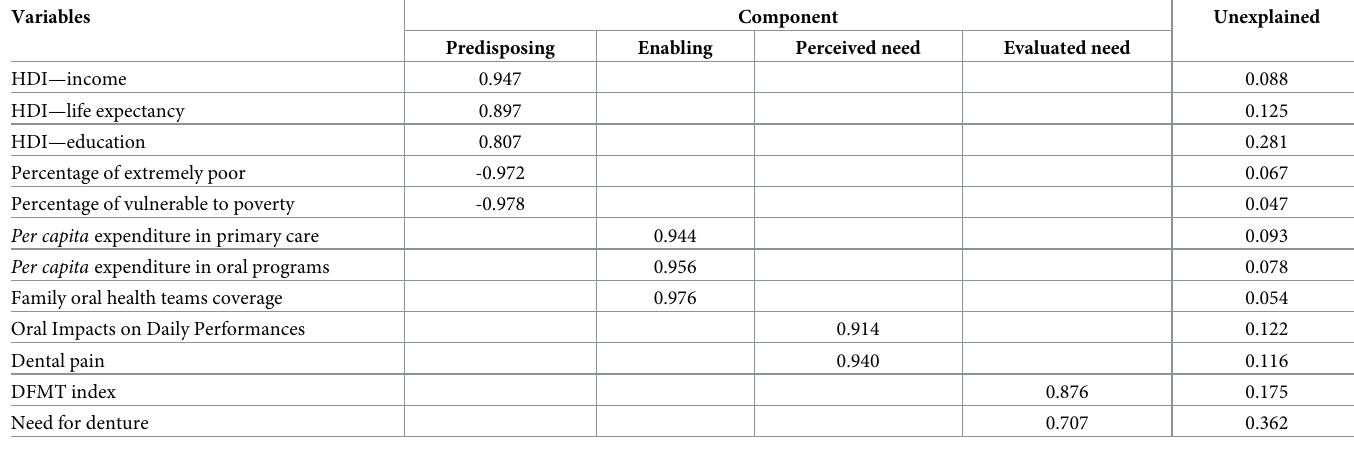
Family oral health teams